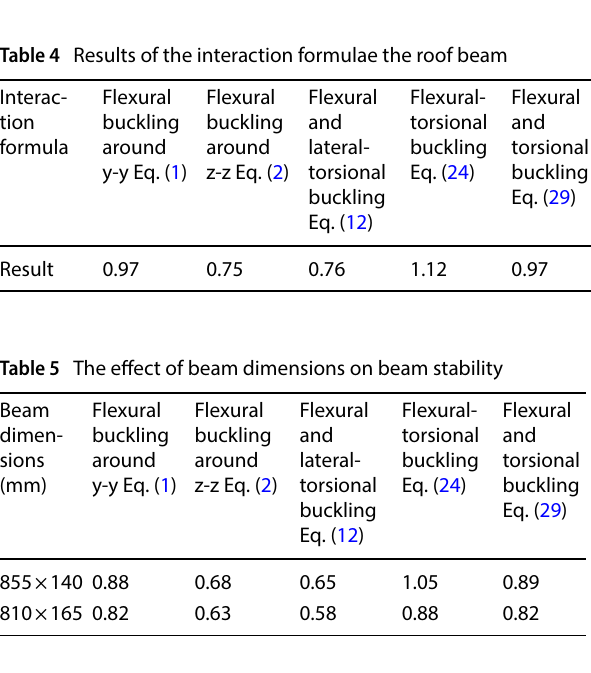
Table 3 Parameters to calculate the interaction formulae Quantity Result